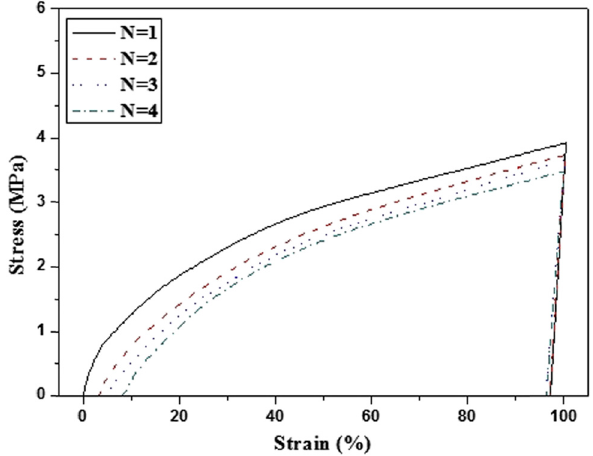
Figure 8: Thermomechanical cyclic behavior of polyurethane/gra - phene 2.5 phr ( 103 ) . N – number of cycles. Reproduced with per - mission from